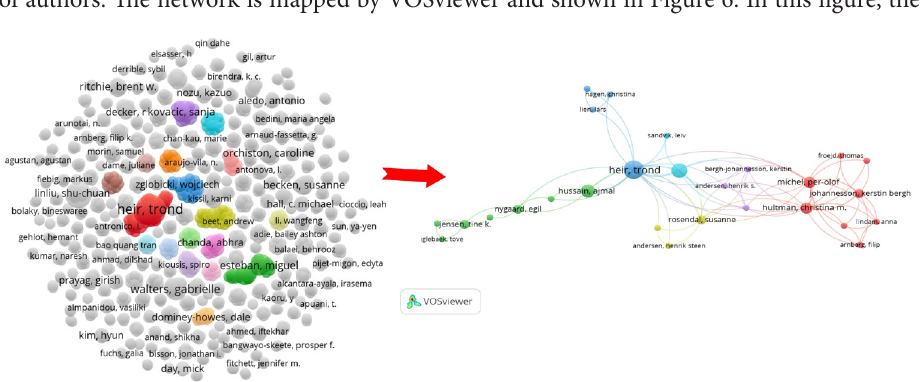
Figure 6. The author collaboration network and maximum